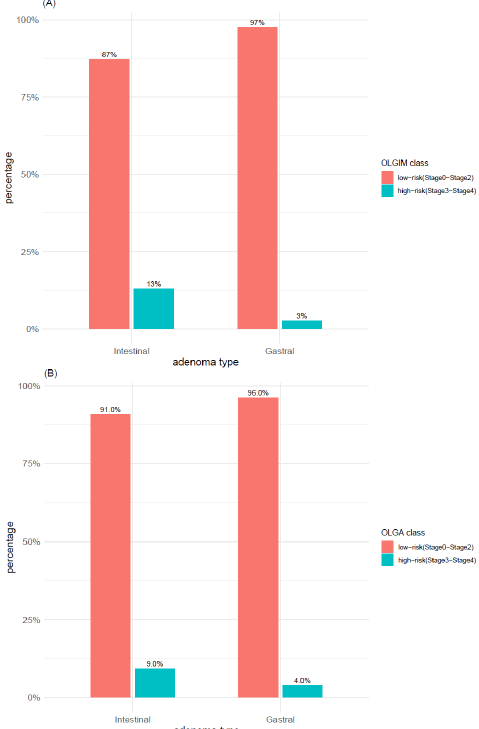
Figure 14. Distribution of ( A ) intestinal metaplasia and ( B ) atrophy within intestinal and gastral adenoma types according to OLGA and OLGIM classes (low-risk vs. high-risk).